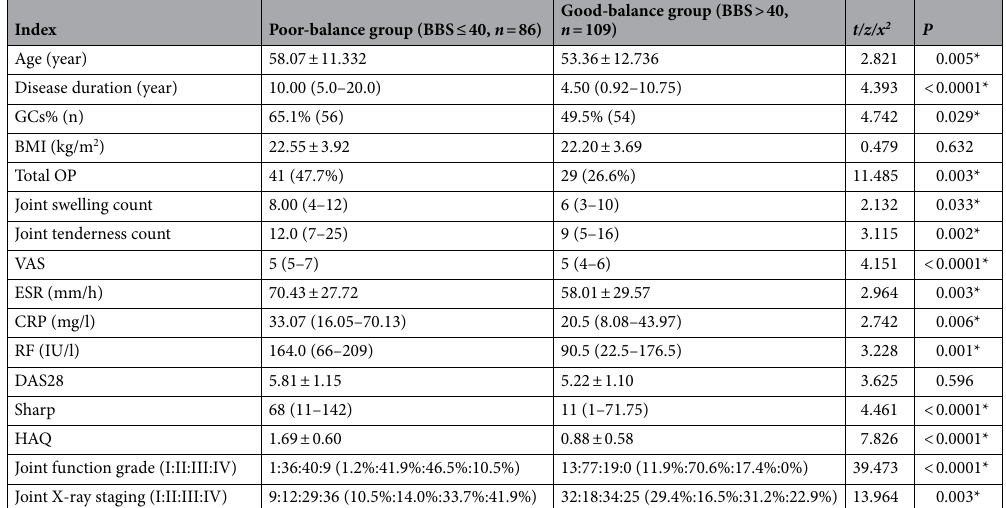
Table 3. Comparison of disease related indexes between female RA with different balance capacity. Mean and standard deviation for the continuous variables and number of participants (n) and percentages (%) for the categorical variables. * P value <